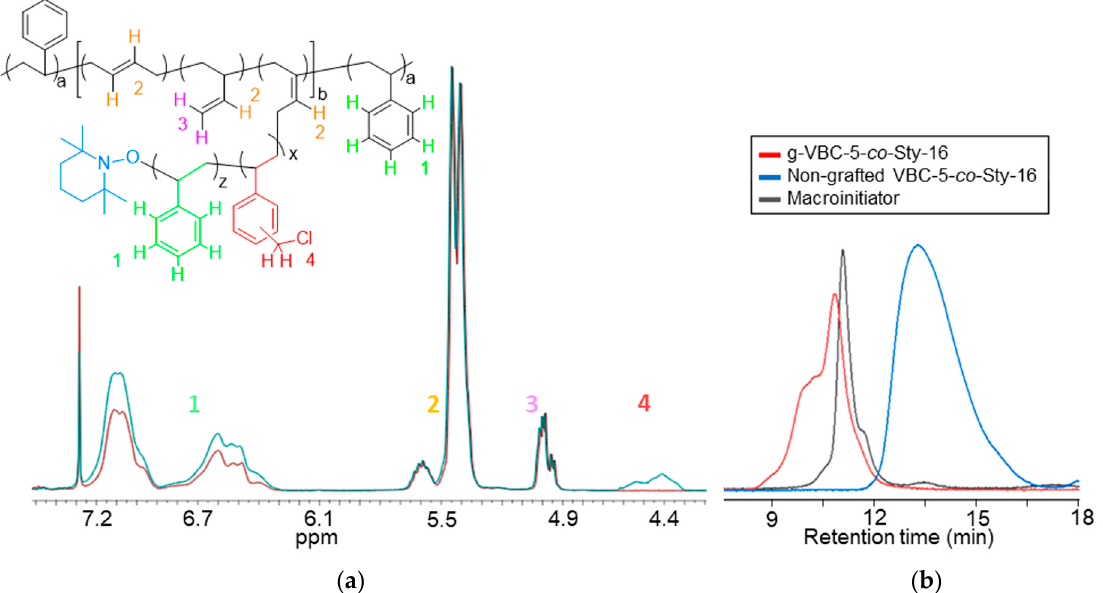
Figure 3. 1 H NMR spectra of the puri fi ed g-VBC-5- co -Sty-16 copolymer (cyan line) and the starting macroinitiator MI (red line) ( a ). The color of the di ff erent protons was chosen as follows: green for styrene, red for VBC, yellow for 1,4-butadiene at 5.6 ppm and 1,2-butadiene at 5.4 ppm, and purple for 1,2-butadiene at 5.0 ppm. GPC curves of the puri fi ed g-VBC-5- co -Sty-16 copolymer, the starting macroinitiator, and the non-grafted copolymer obtained using the UV-detector at λ = 252 nm ( b ).